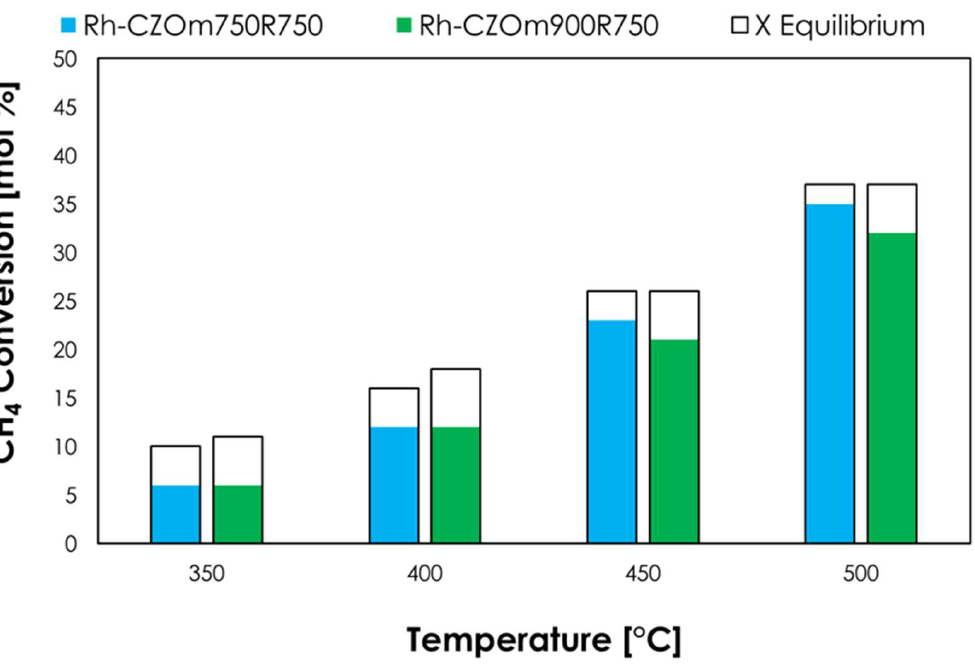
Nanomaterials 2023 , 13 , 53 Figure 8. Methane conversion (colored bars) and equilibrium conversion (transparent bars) for LTSR at 1 atm, S/C = 3 and 24,000 h −1 for Rh-CZOm750-R750 and Rh-CZOm900-R750.